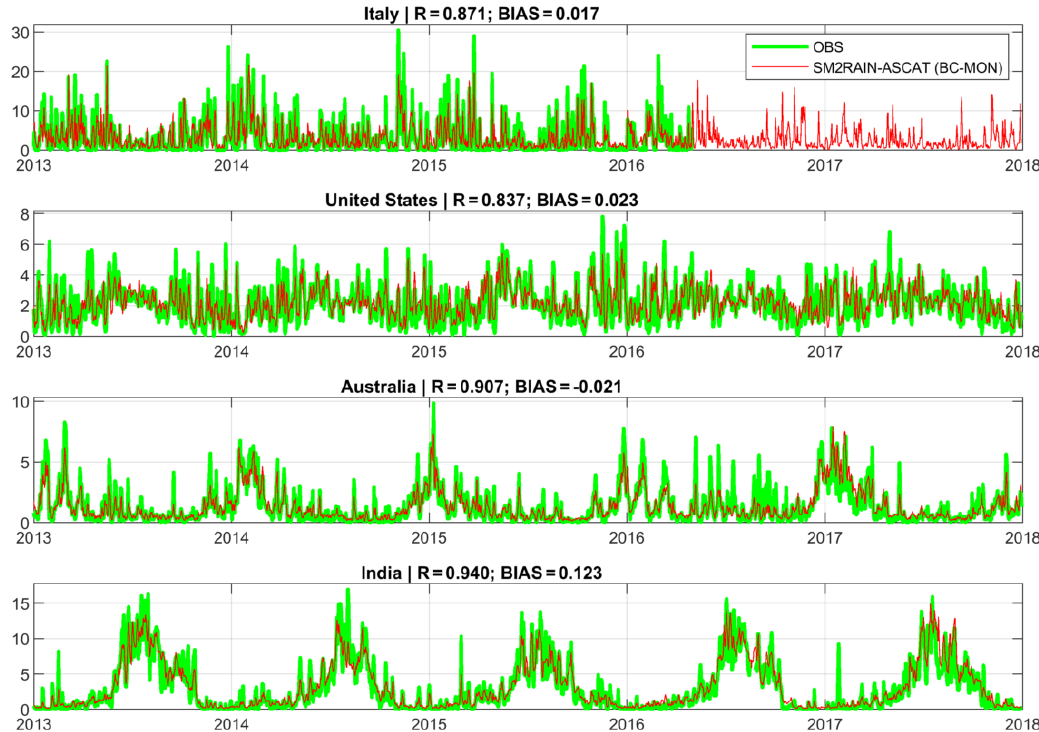
Figure 4. Time series of mean areal rainfall for the four regions for observed data, OBS, and the SM2RAIN–ASCAT data record, BC-MON configuration ( R (–): Pearson’s correlation, BIAS (mmd − 1 ): mean error).